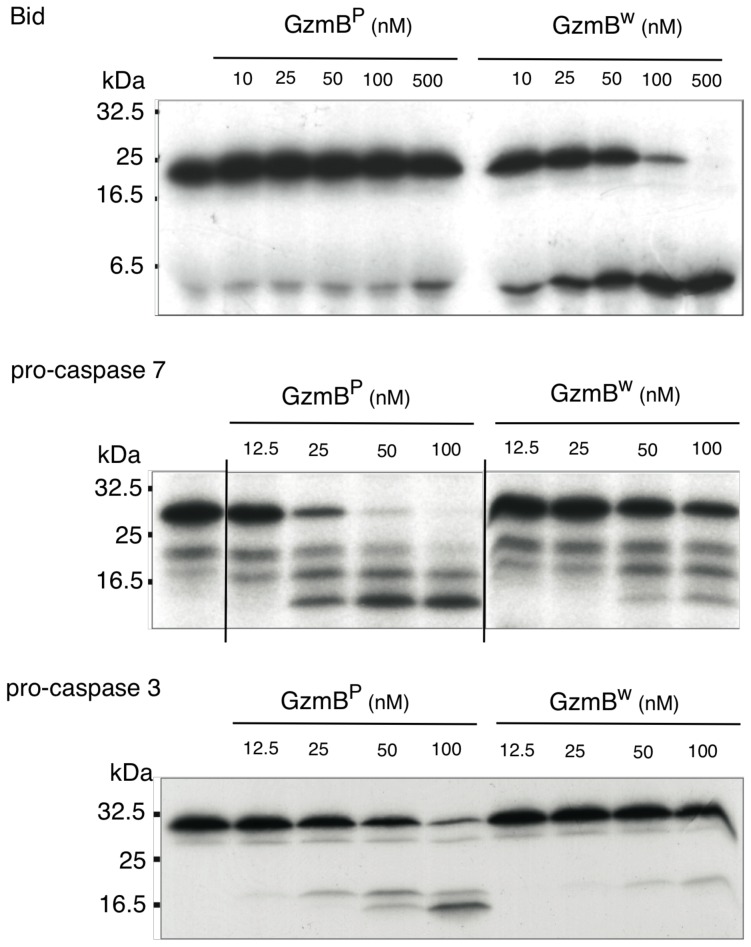
GzmBW cleaves Bid more efficiently and procaspases less efficiently than GzmBP.
In vitro translated 35S-labeled mouse procaspase 3, mouse procaspase 7, or mouse Bid were incubated with the indicated amounts of granzymes at 37°C for 30 min. Products were separated by 15% SDS-PAGE and visualized by fluorography.